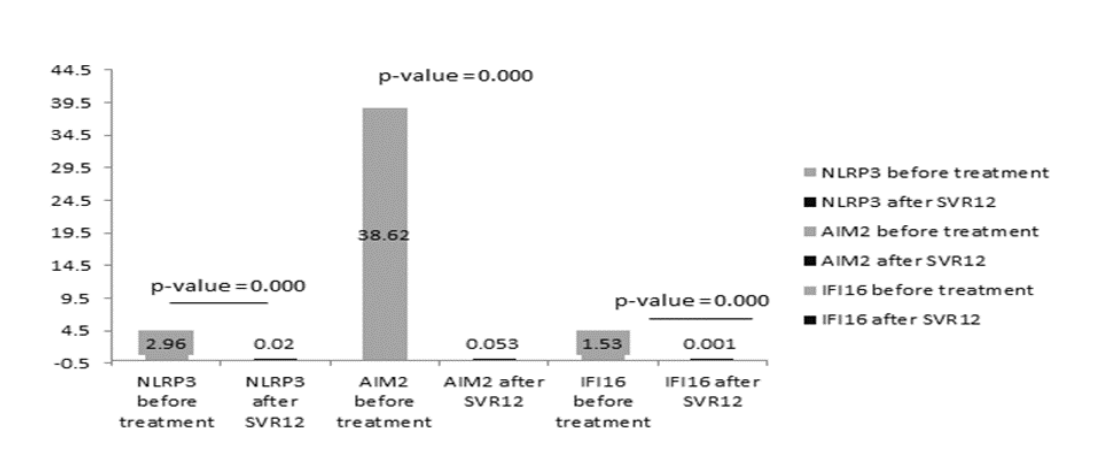
Figure 3. Showing IL-18 serum level in chronic HCV patients before treatment in comparison to healthy controls. Data expressed as